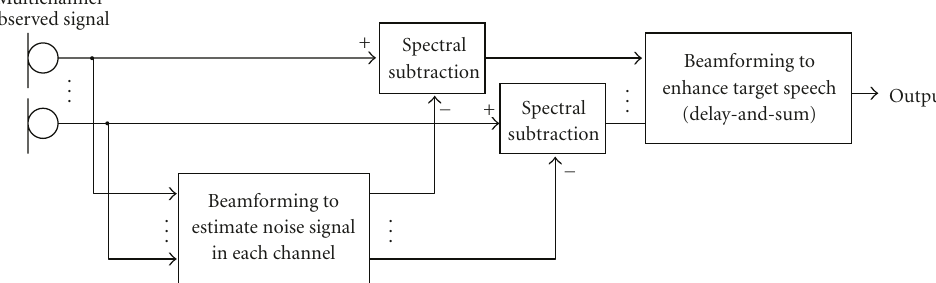
Figure 2: Block diagram of architecture for channelwise spectral subtraction before beamforming (chSS+BF).